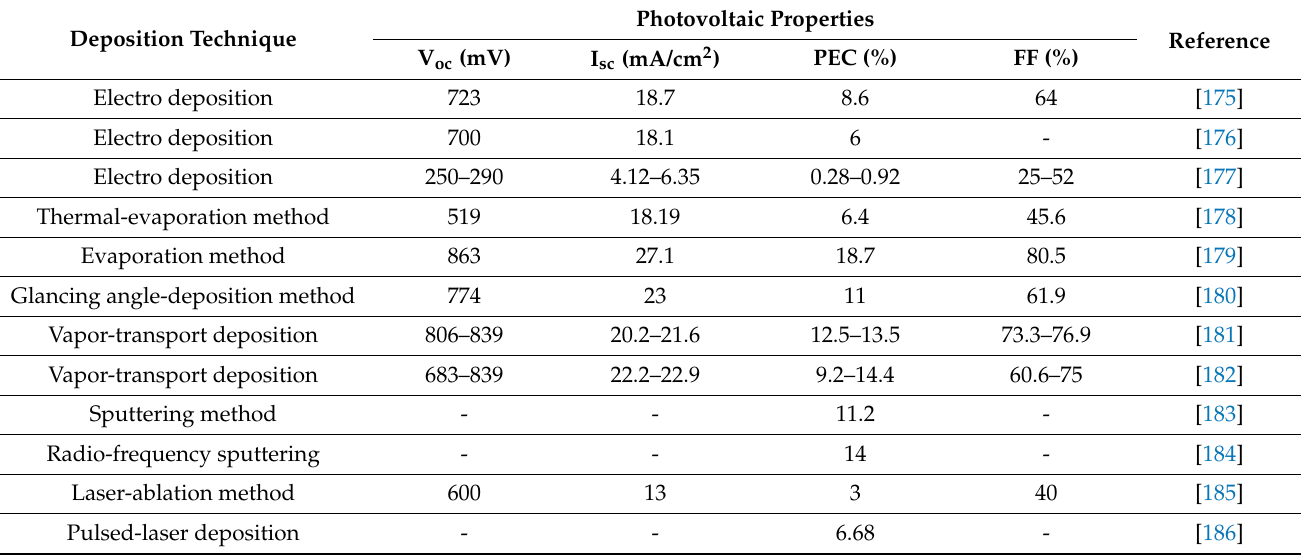
Table 2. The growth of CdTe films using various deposition methods and the photovoltaic properties.